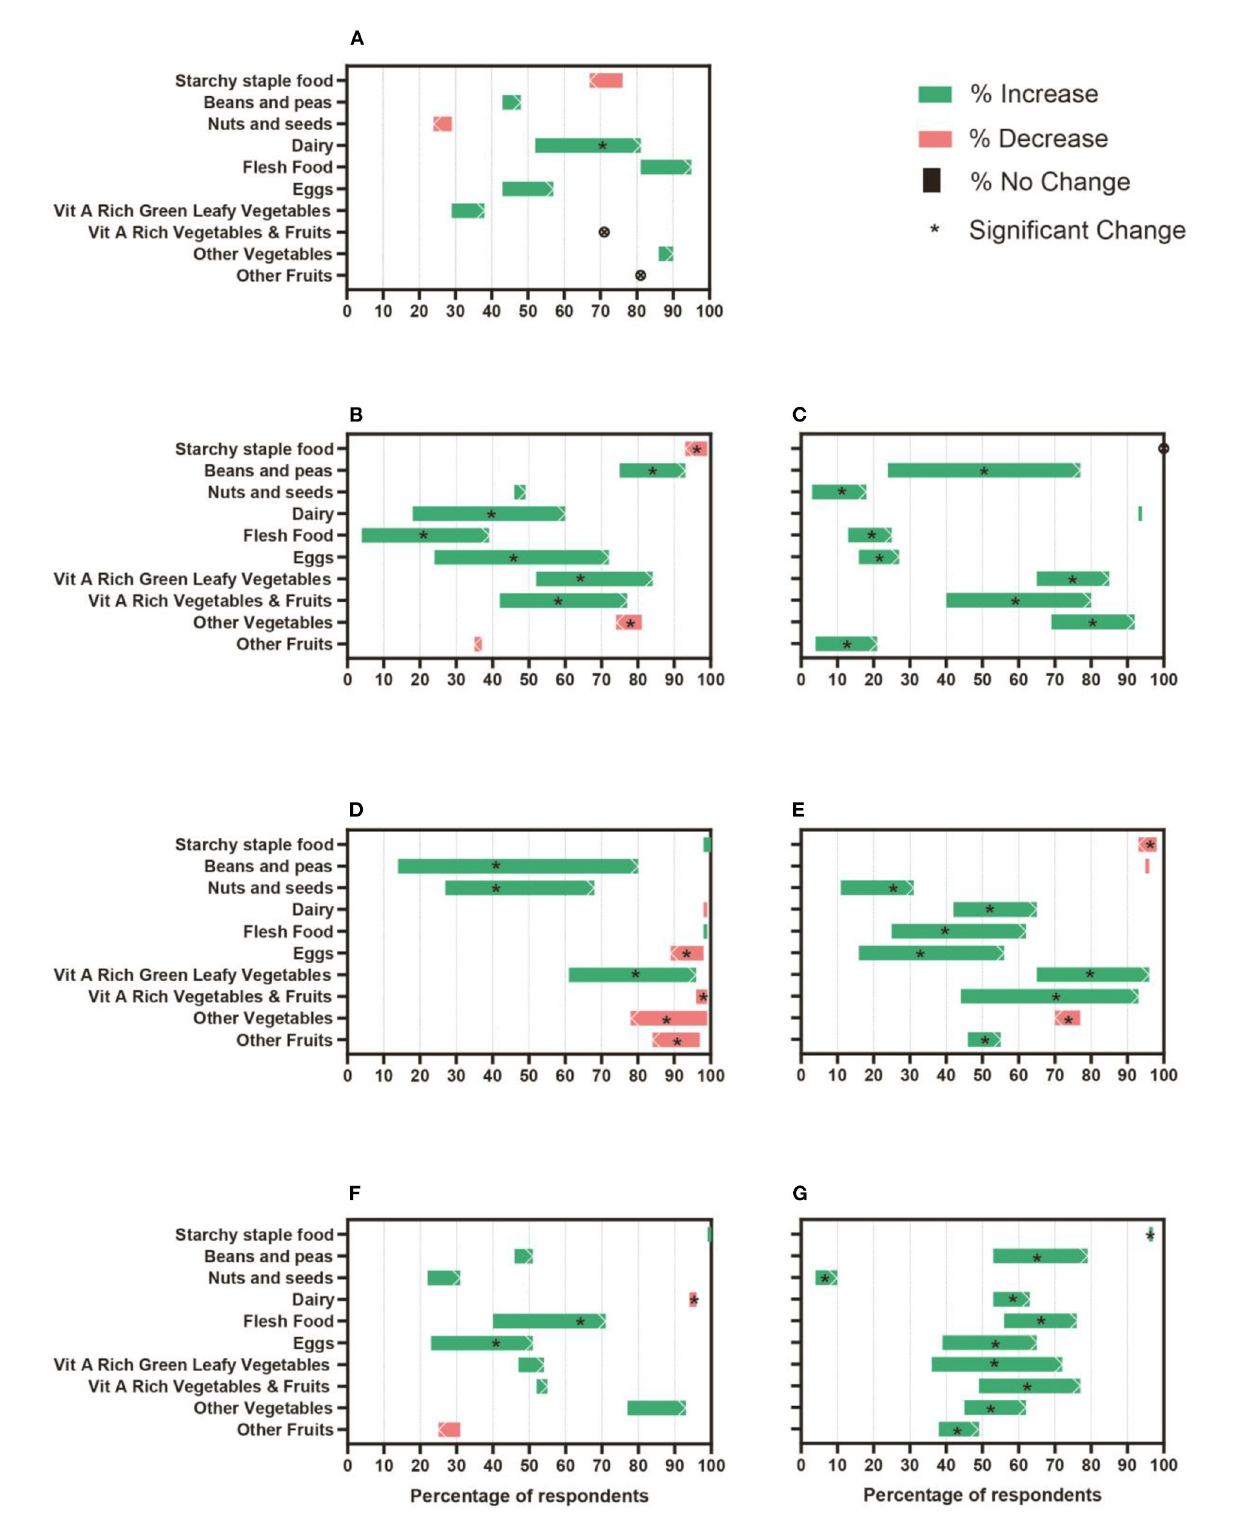
FIGURE4 Dietary changes in percentage among target populations before and after the implementation of SUNSAIs in different project countries: (A) Ecuador, (B) Ethiopia, (C) India, (D) Kyrgyzstan, (E) Nepal, (F) Pakistan, and (G) Peru.